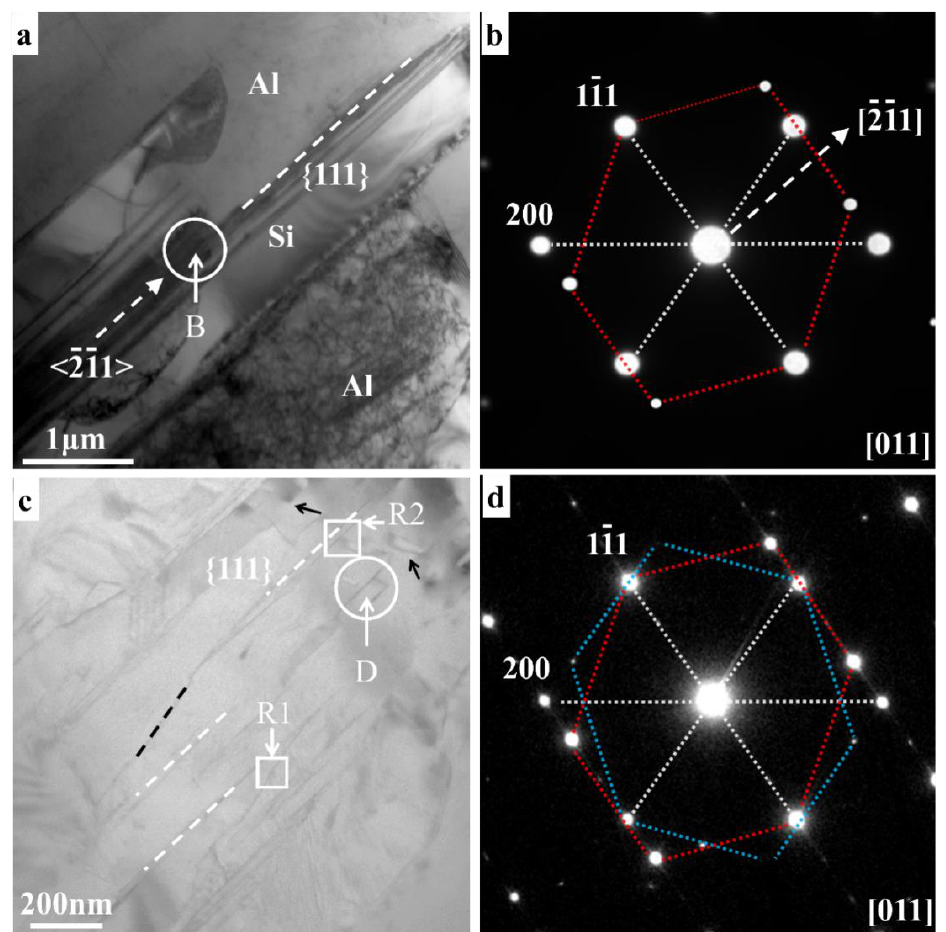
Figure 1. Low magnification TEM images and corresponding selected area diffraction pattern (SADP) of eutectic Si in different Al-Si alloys, viewed from the [011] zone axis, ( a ) the eutectic Si in Al-7Si alloy; ( b ) the SADP taken from the white circle B; ( c ) the eutectic Si in Al-7Si-50 ppm Ba alloy; ( d ) the SADP taken from the white circle D.